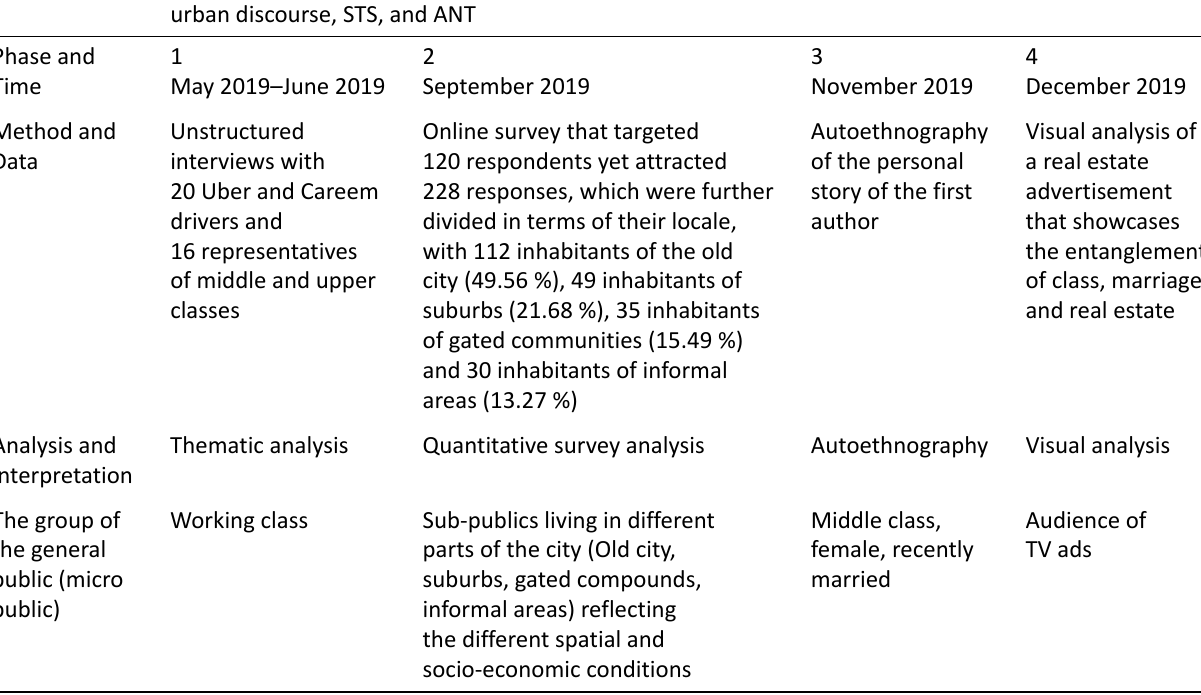
Table 1. The mixed-method research methodology.